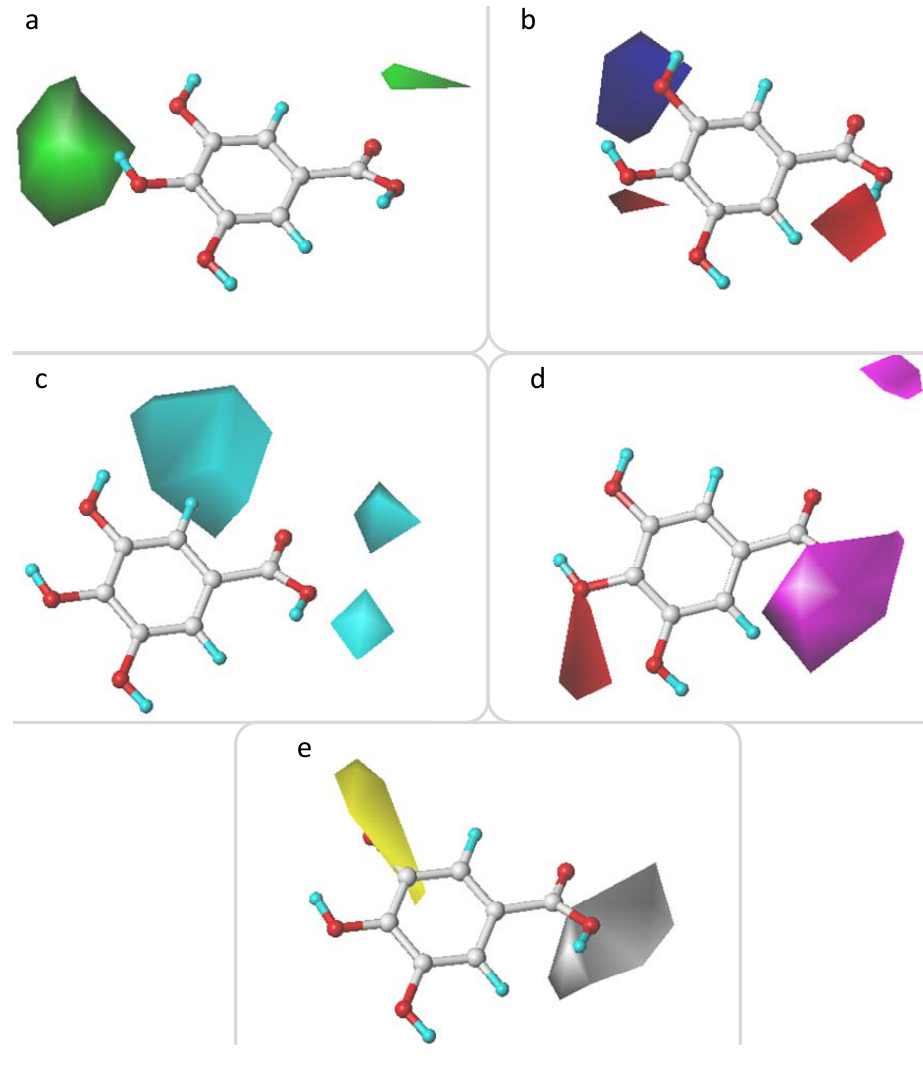
Figure 2. CoMSIA contour maps. ( a ) steric contour map: the green is sterically favored for the activity , whereas the yellow is unfavorable; ( b ) electrostatic contour map: the blue for positive-charged substituent is favorable, whereas the red for the negative-charged substituent is favorable; ( c ) hydrogen bond donor contour map: the cyan for hydrogen bond donors is favorable whereas the purple for hydrogen bond donors is unfavorable for the activity; ( d ) hydrogen bond acceptor contour map: the magenta for hydrogen bond acceptors is favorable for the activity whereas the red for hydrogen bond acceptors is unfavorable for the activity; ( e ) hydrophobic contour map: the yellow for hydrophobic group is favorable whereas the grey for hydrophobic group is